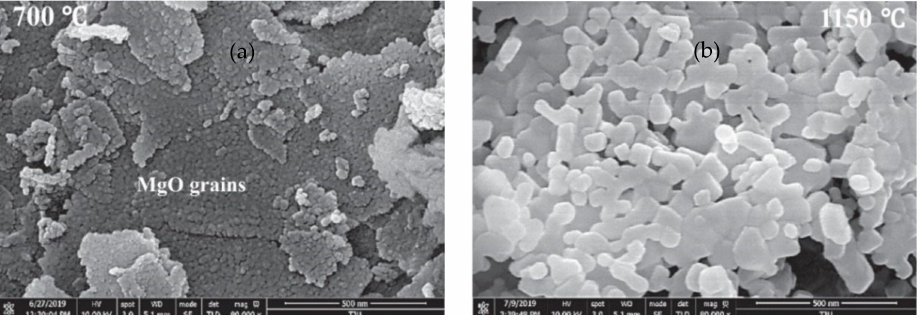
Figure 2. Microstructure comparison of MgO with different reactivity: ( a ) MgO with high